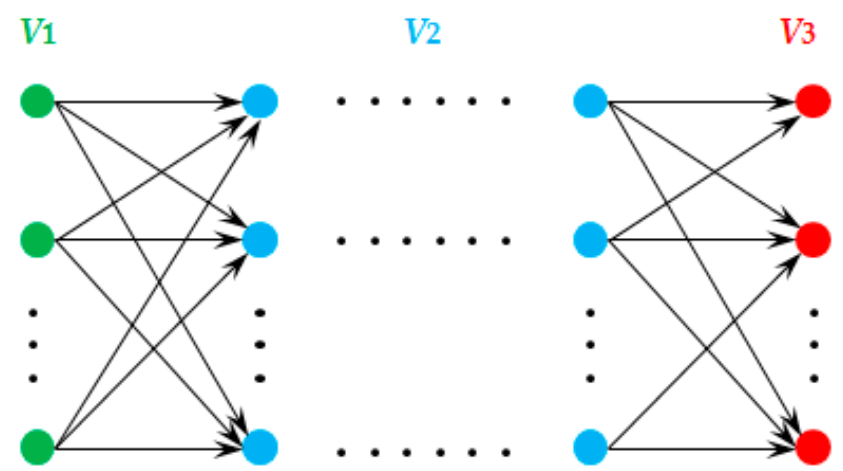
Figure 3. An evacuation network with multi-origin and multi-destination.